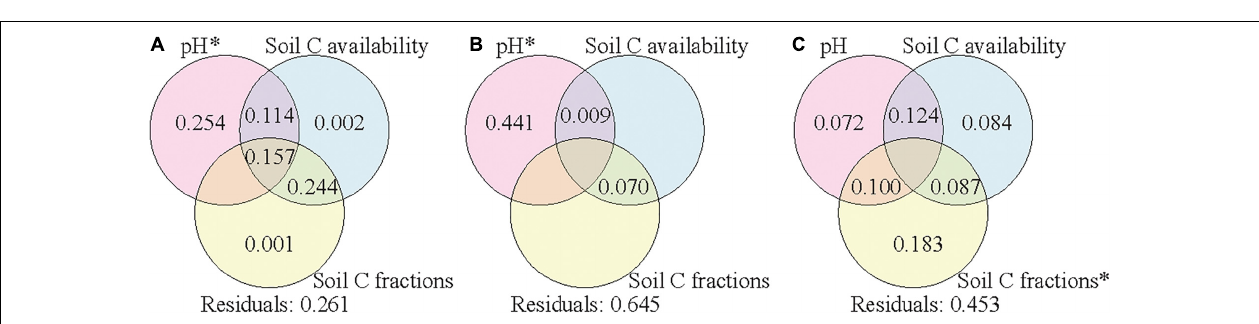
FIGURE 4 | Spearman’s rank correlations between the relative abundances of the dominant bacterial taxa and the selected soil properties in the surface soil layer (A) , subsurface soil layer (B) , and deep soil layer (C) . The correlation coefficients ranging from negative to positive are indicated by color intensity changing from dark blue to red, as illustrated by the figure legend. MAT, mean annual temperature; MAP, mean annual precipitation; Div, Shannon’s index of trees; BA, the sum of breast-height basal areas of trees; TD, tree density; SIN, soil inorganic nitrogen (NH 4 + + NO 3 − ); POC%, proportion of particulate organic carbon in SOC; LPI%, proportion of labile carbon I in SOC; LPII%, proportion of labile carbon II in SOC; RP% proportion of recalcitrant carbon in SOC; M o :SOC, mole ratio of poorly crystallized Fe and Al to SOC. Acido, acidobacteria; δ -pro, delta-proteobacteria; Planc, planctomycetes; Gemma, gemmatimonadetes; Chlor, chloroflexi; Nitro, nitrospirae; Actin, actinobacteria; α -pro, alpha-proteobacteria; Bacte, bacteroidetes; β -pro, beta-proteobacteria; γ -pro, gamma-proteobacteria. represents a significant relationship at p < 0.1, * p < 0.05; ** p < 0.01; *** p < 0.001. p -Values were corrected for multiple testing using the Benjamini and Hochberg method.